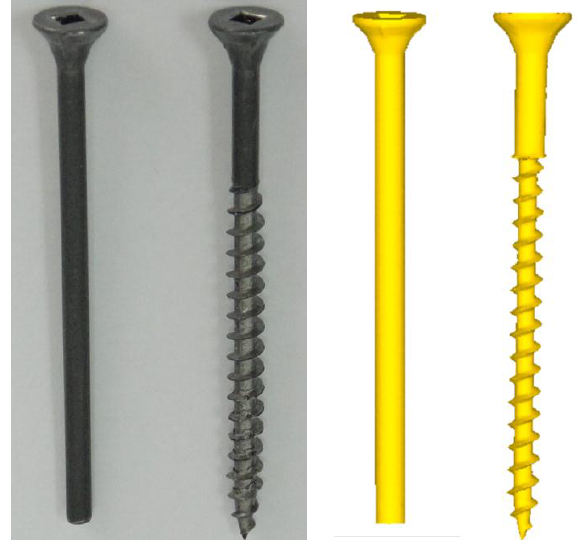
Figure 10. Simulated workpieces and actual sheet metal tapping screw.